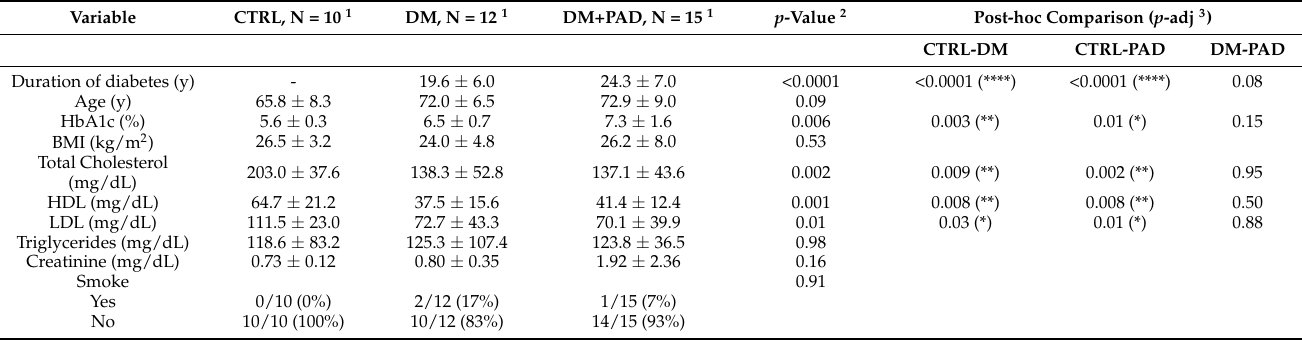
Table 1. Baseline characteristics of the 10 healthy and 27 diabetic subjects under